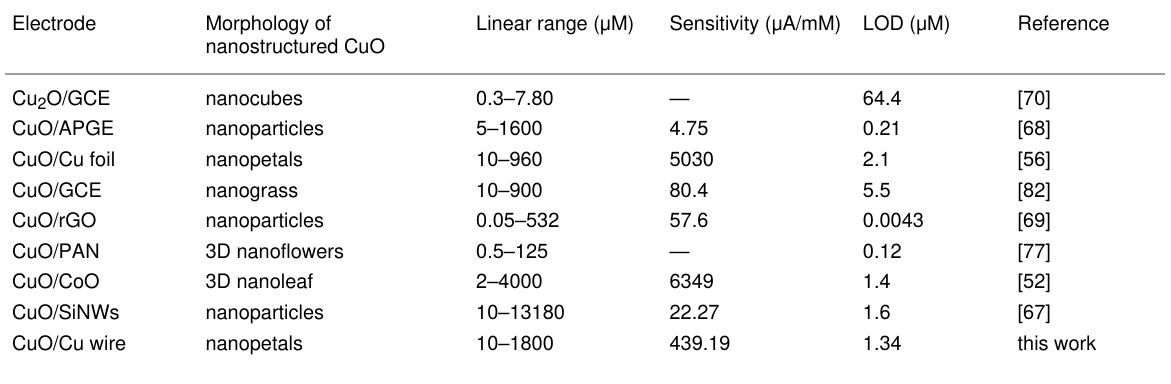
Table 1: Analytical performance of the CuO sensor in this study compared with other reported H 2 O 2 sensors.